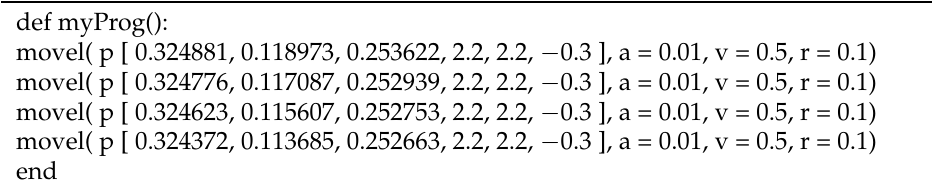
Table 1. URScript program example for